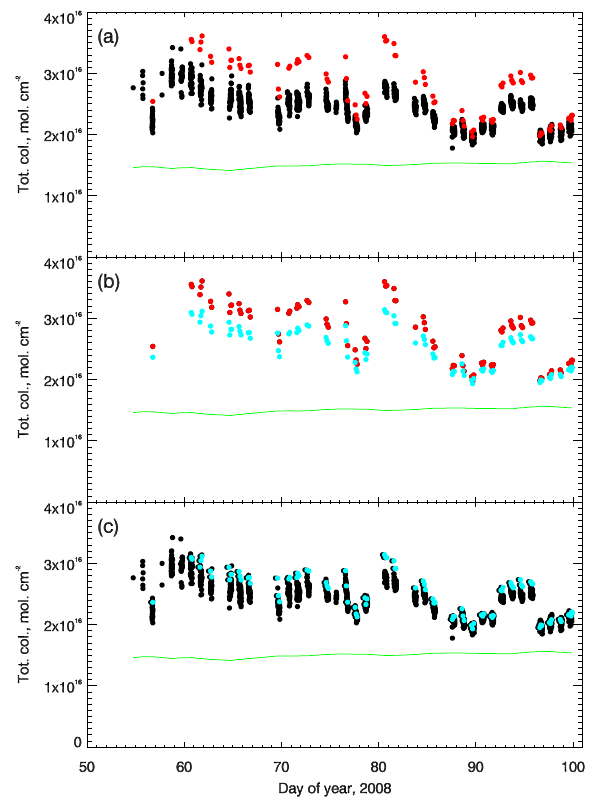
Fig. 2. Illustration of the smoothing process defined by Eq. (1). (a) shows the total HNO 3 column measured by the 125HR in red, and by PARIS-IR in black. The a priori column is shown by the green line. (b) shows the same 125HR measurements in red, and the resulting 125HR measurements after smoothing via Eq. (1) in cyan. (c) shows the new comparison between the smoothed 125HR (cyan) and PARIS-IR